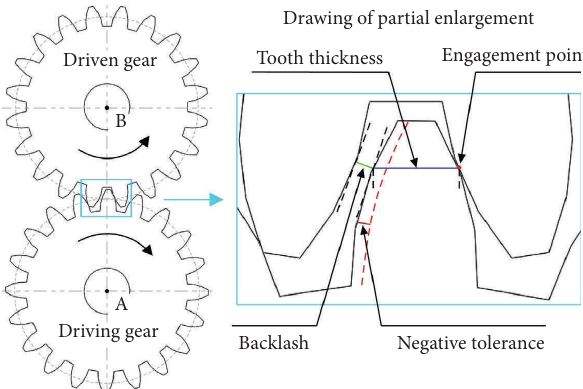
Figure 12: Te geometric relationship of backlash in gear transmission